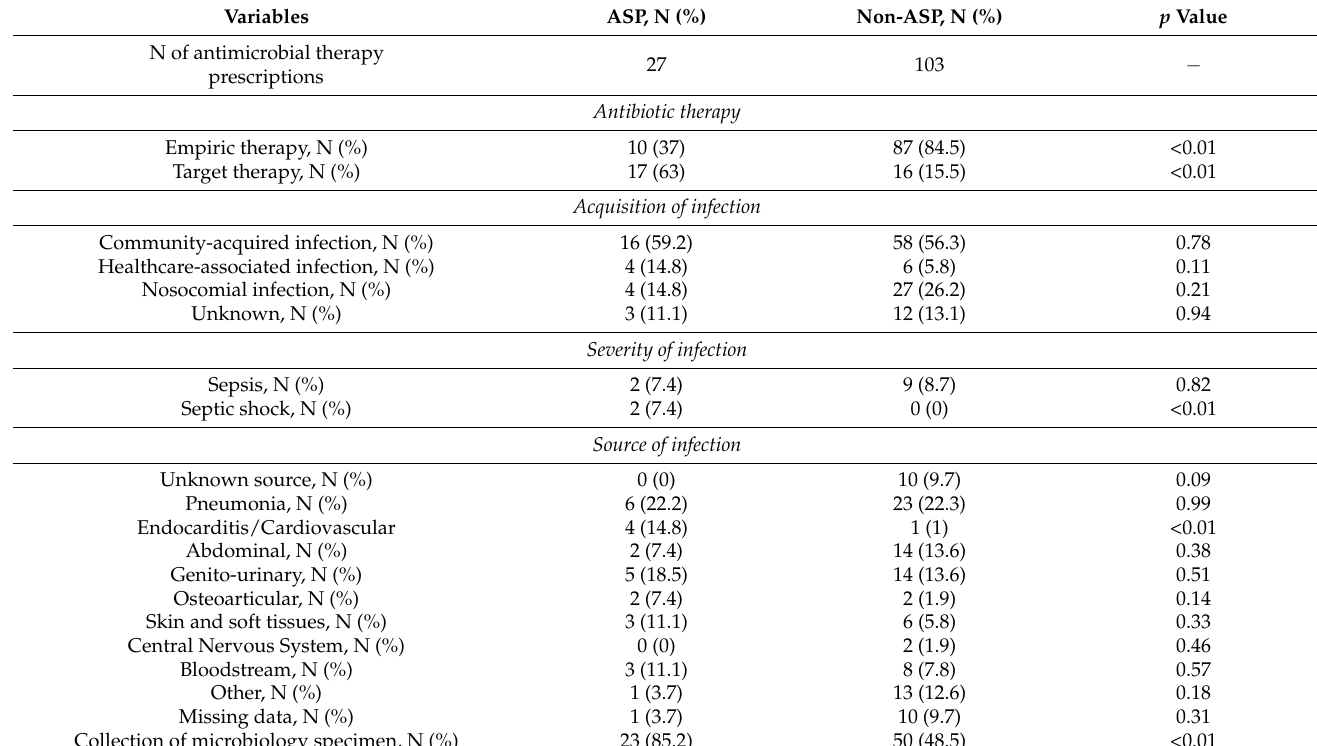
Table 4. Adequacy of antimicrobial therapy between ASP and non-ASP